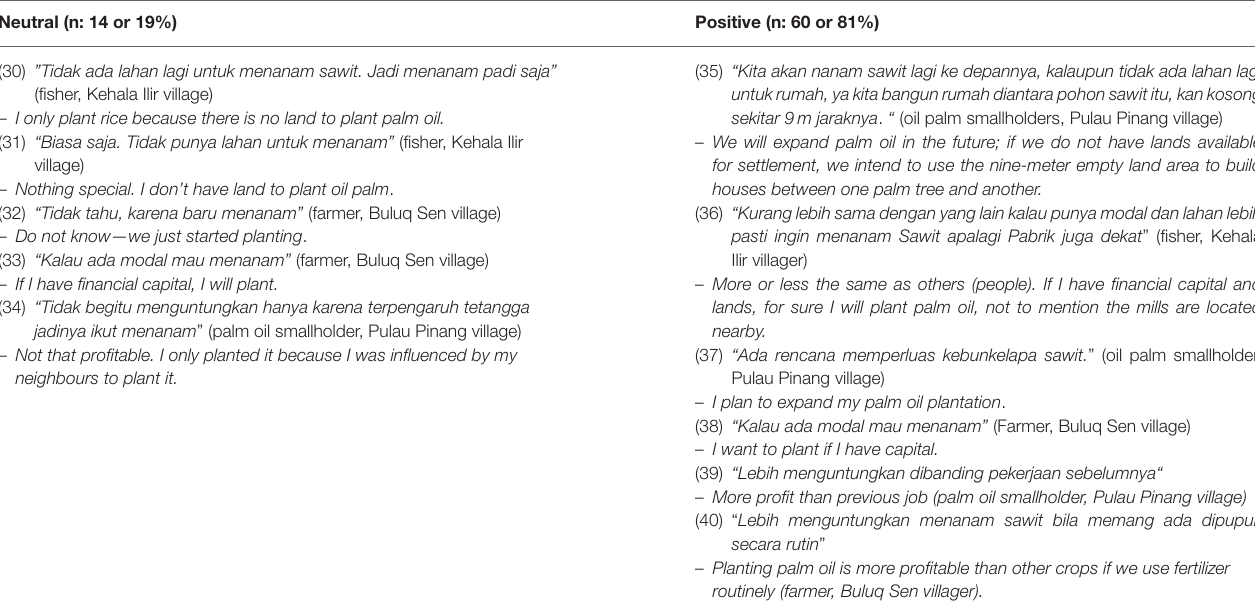
TABLE 6 | Perceptions of communities in Kutai Kertanegara on palm oil development ( n : 74). Neutral (n: 14 or